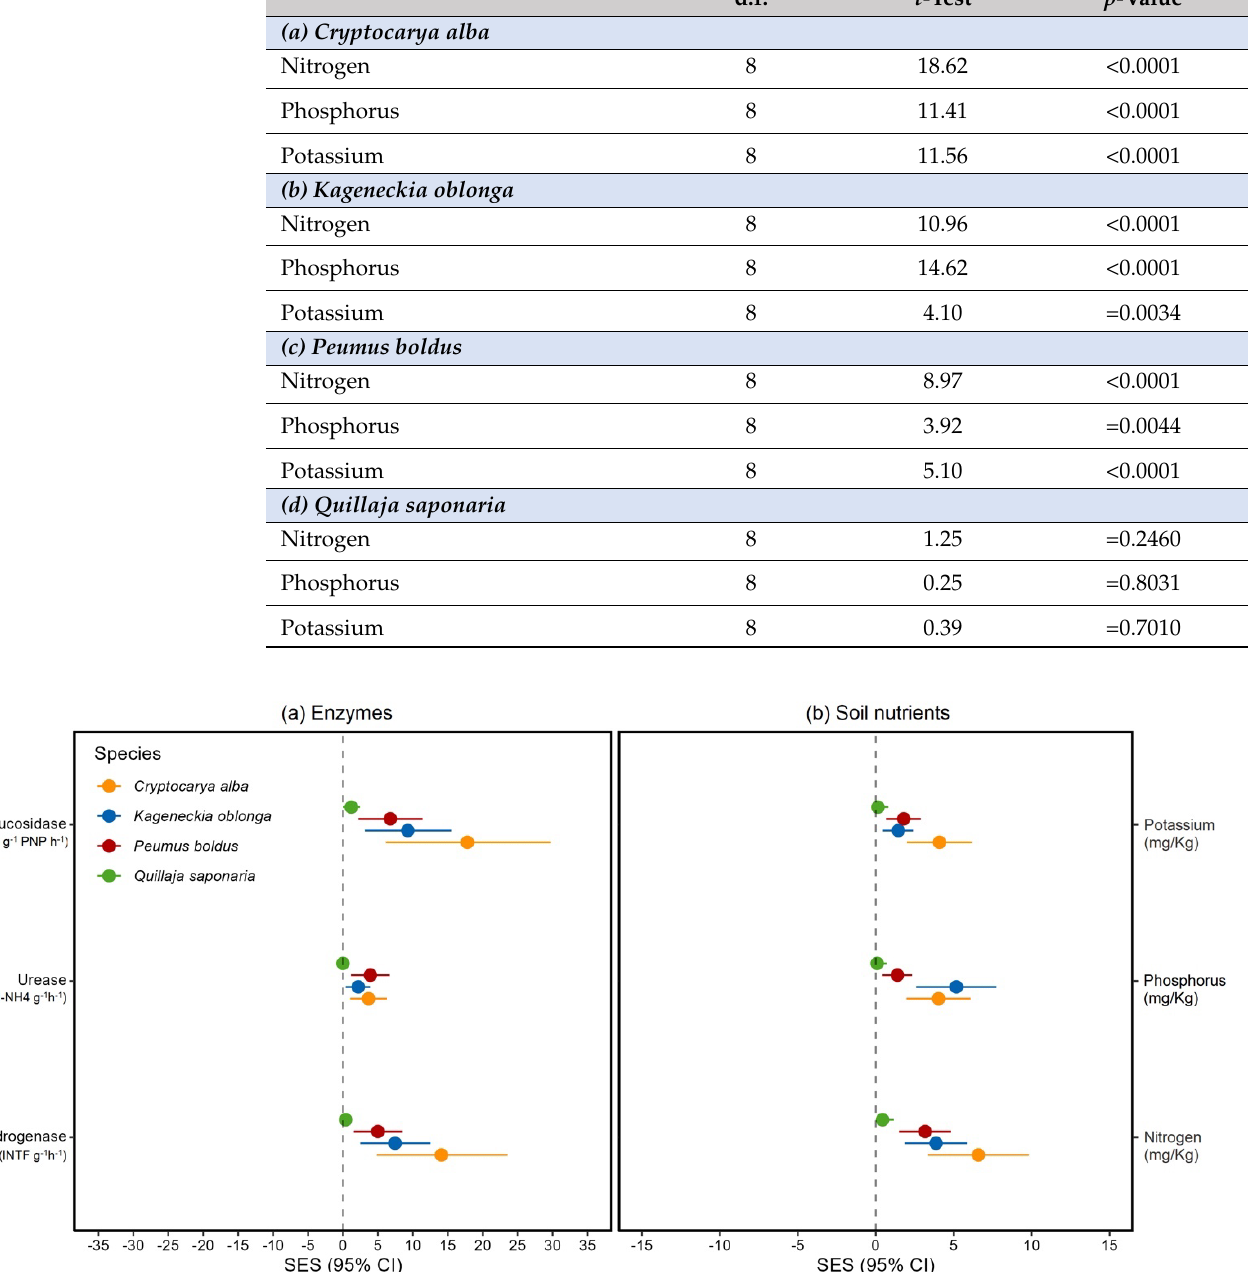
Table 4. Results of t -test of macro-nutrients for the four tree species inoculated (M+) and not inoculated (M − ) with AMF. Degrees of freedom (d.f.), t -values, and p -values are shown. Significant differences are denoted in red color. d.f. t -Test p -Value